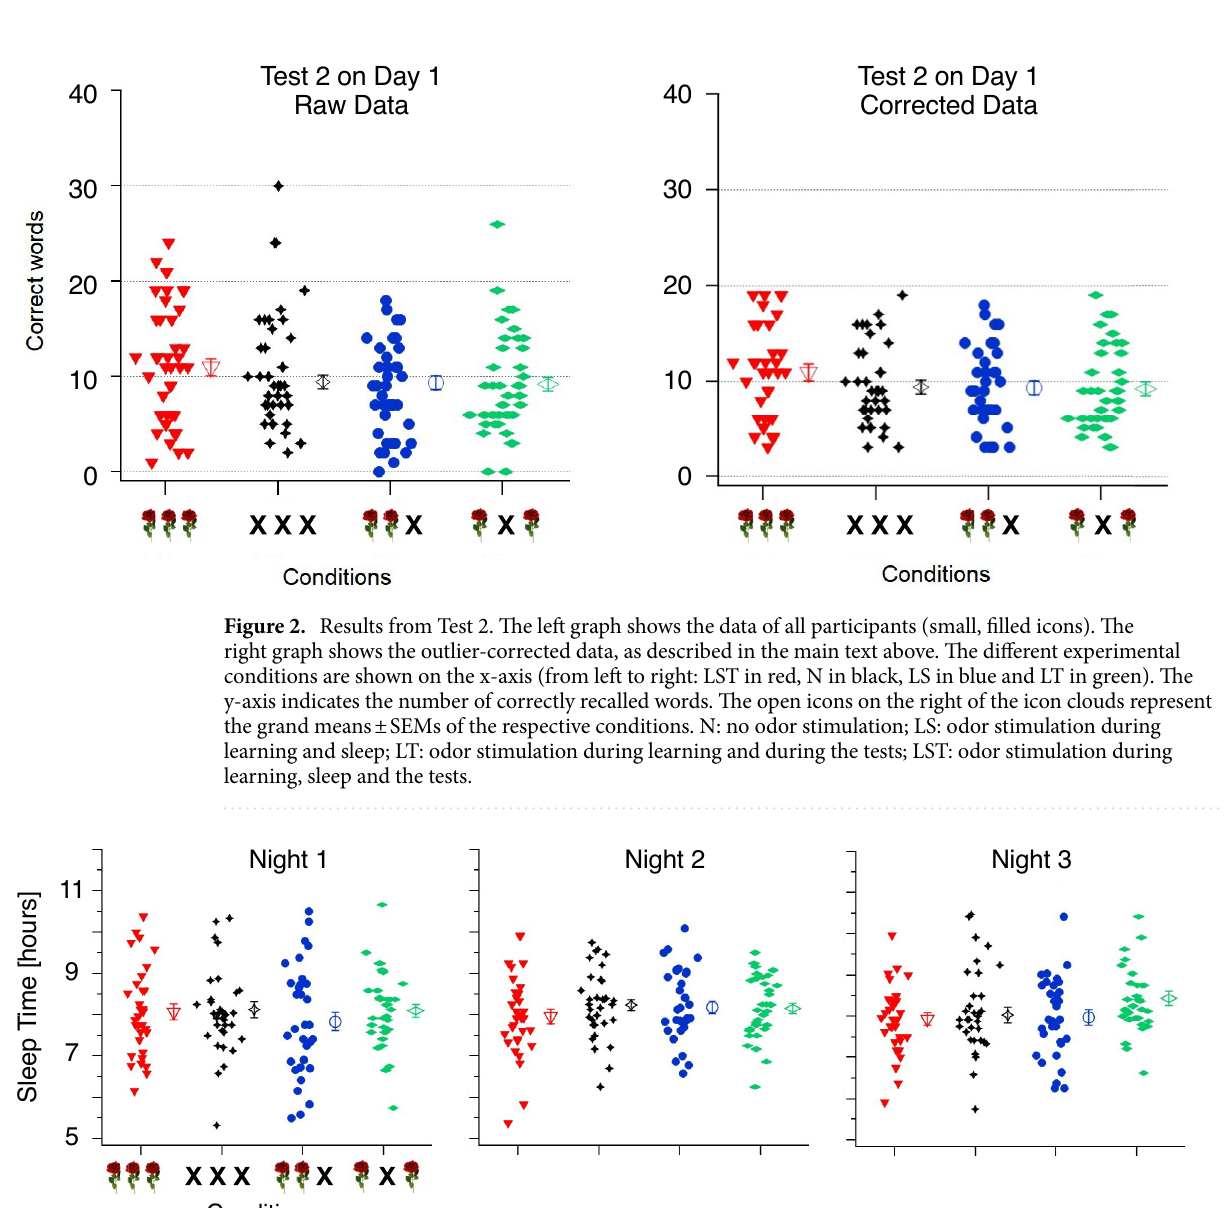
Figure 3. Sleep times. The sleep times for all participants (of the corrected data) of each condition are shown separately for the first three nights. The different conditions are displayed on the x-axis, LST in red, N in black, LS in blue and LT in green. The sleep time in hours, as reported by the participants, is shown on the y-axis. Each filled icon represents data from one participant. The open icons on the right-hand side of each cloud of illed icons represent the grand means (larger unfilled icons) ±